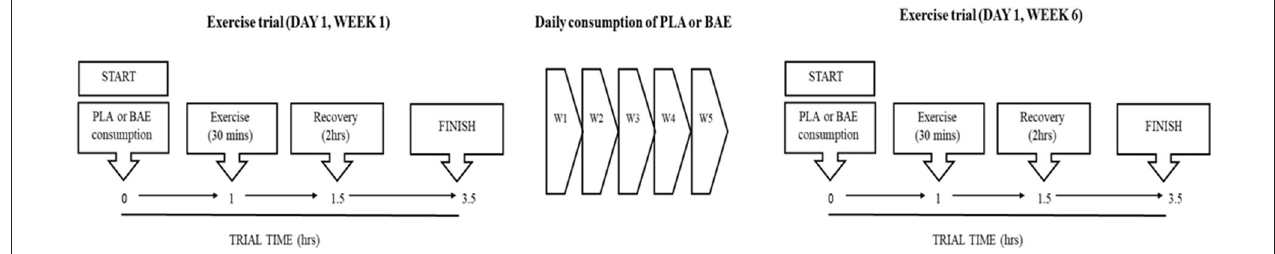
FIGURE 1 | Flow chart of the 6 week study design to examine the efficacy of daily blackcurrant anthocyanin-rich extract (BAE) consumption for 5 weeks on the recovery from exercise-induced oxidative stress and systemic immune defense biomarkers. PLA, placebo.